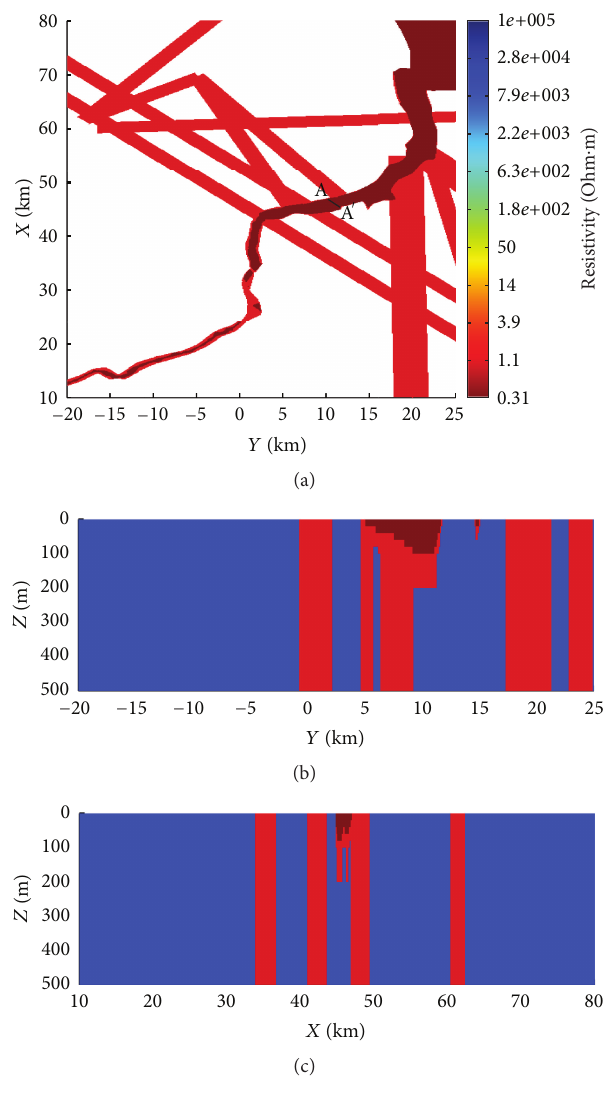
Figure 5: The initial geoelectric model, (a) XY section at 𝑧 = 0 m, (b) YZ section at 𝑥 = 45.36 km, and (c) XZ section at 𝑦 = 11.19 km . The line AA 󸀠 represents the profile of observations corresponding to the sites from 5 to 1 inFigure